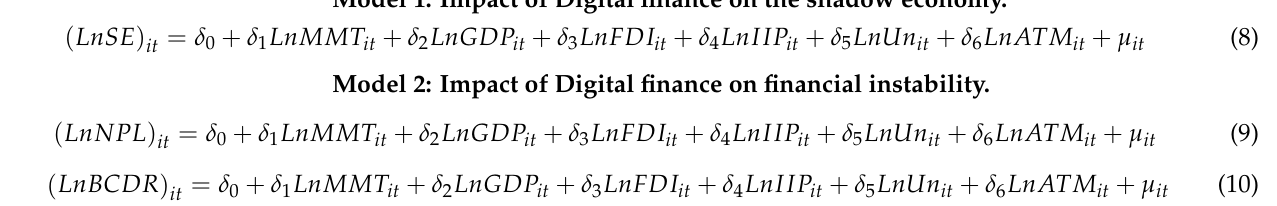
Model 1: Impact of Digital finance on the shadow economy. Model 2: Impact of Digital finance on financial instability.